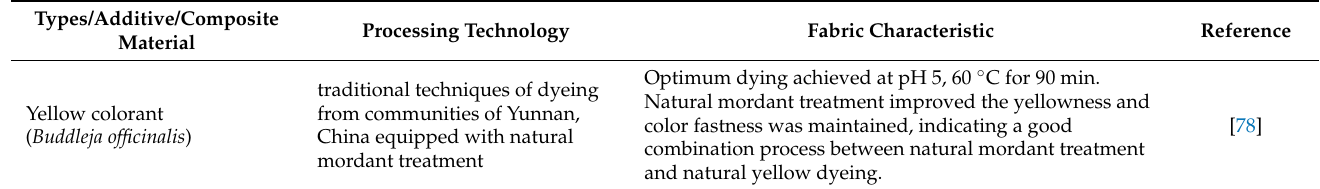
Table 3. Related researches on application of hemp fiber in textile